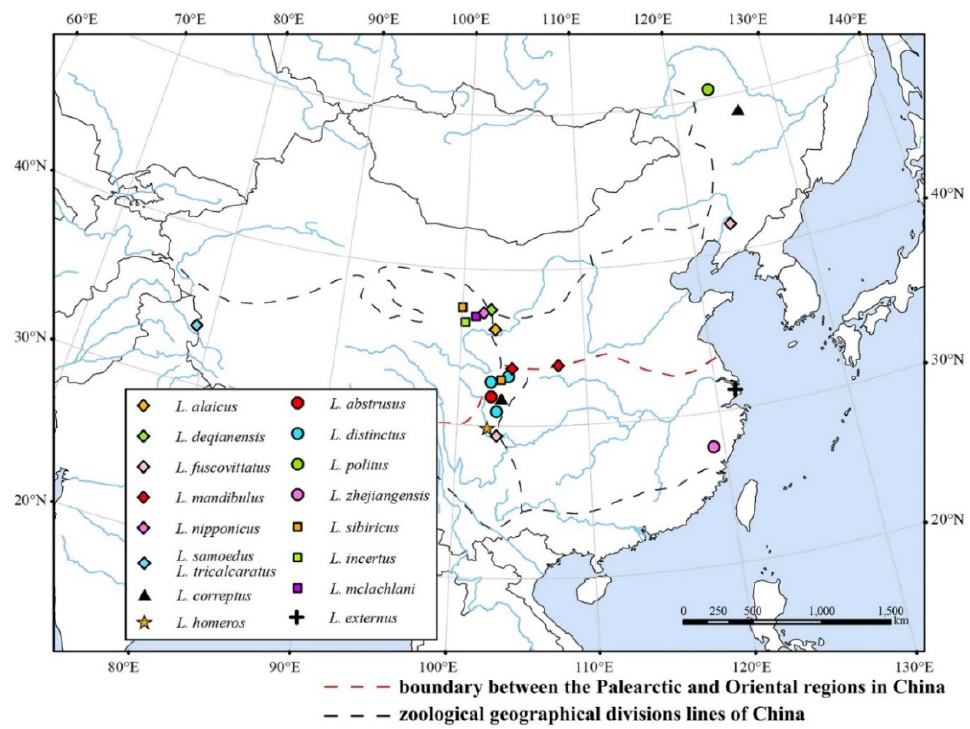
Figure 19. Distribution of Limnephilus species on the Chinese mainland. Diagnosis : (1) Aedeagus long and thick with the extensible extremity bearing an external hook; (2) parameres, each slender, with triplet apices in the dorsal view. Type country :